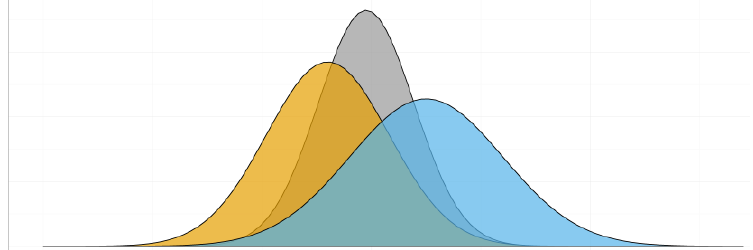
Figure 1. An illustration of the basic principle of data assimilation applied to a Gaussian model and estimate. The figure shows how the prior forecast (the center of the orange distribution) is updated to the posterior forecast (the center of the grey distribution) when a new estimate (the center of the blue distribution) is taken into account. Notice that the grey distribution is narrower than the orange distribution, indicating that the posterior forecast is more precise ( i.e. , the estimate has lower variance) than the prior forecast.